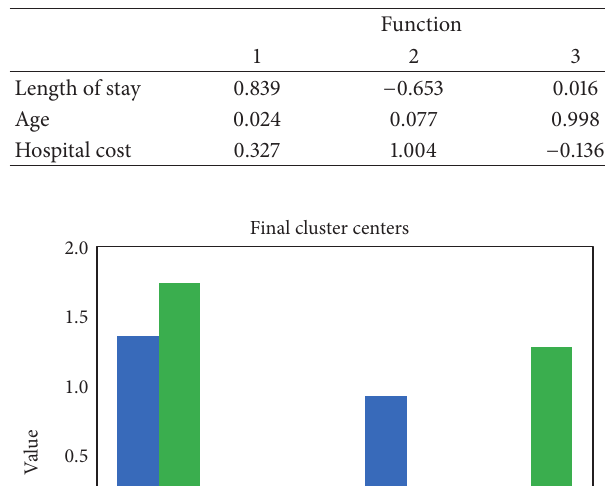
Table 3: Standardized canonical discriminant function coefficients.